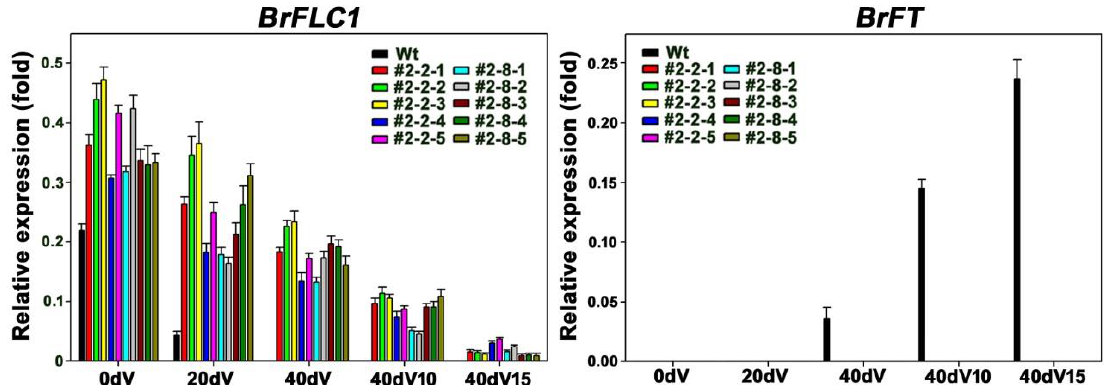
Figure 5. Expression patterns of floral regulator genes in ‘transgene - free’ BrVRN1 mutant GE2 lines. BrFLC, B. rapa FLOWERING LOCUS C; FT, FLOWERING LOCUS T. 0dV, 20 day-old plants before cold treatment (4 °C); 20dV, 20-day exposure to 4 °C; 40dV, 40-day exposure to 4 °C; 40dV10 and 40dV15, 10 days and 15 days at 25 °C after a 40-day exposure to 4 °C, respectively. Wt, untransformed wild-type plants; lanes #2-2-1 to #2-8- 10, selected ‘transgene - free’ GE2 mutant lines, respectively.